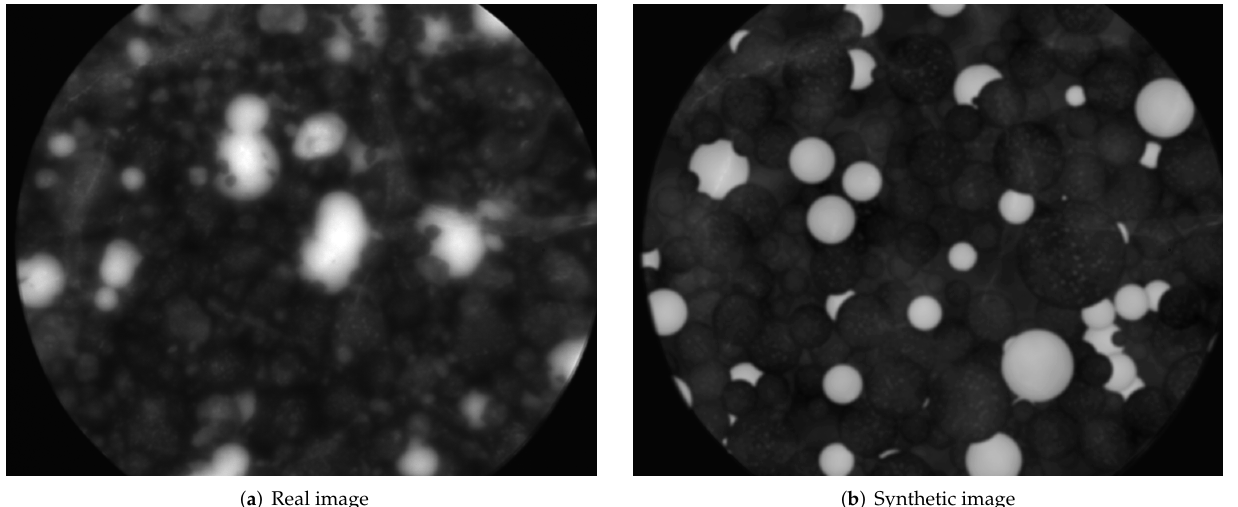
Figure 1. Example of a real image ( a ) used for testing and a synthetic image ( b ) used for training and validation of proposed